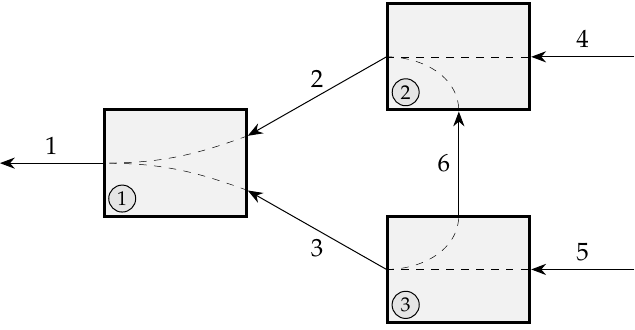
Figure 5. Dual cost structure of generic plant in Figure